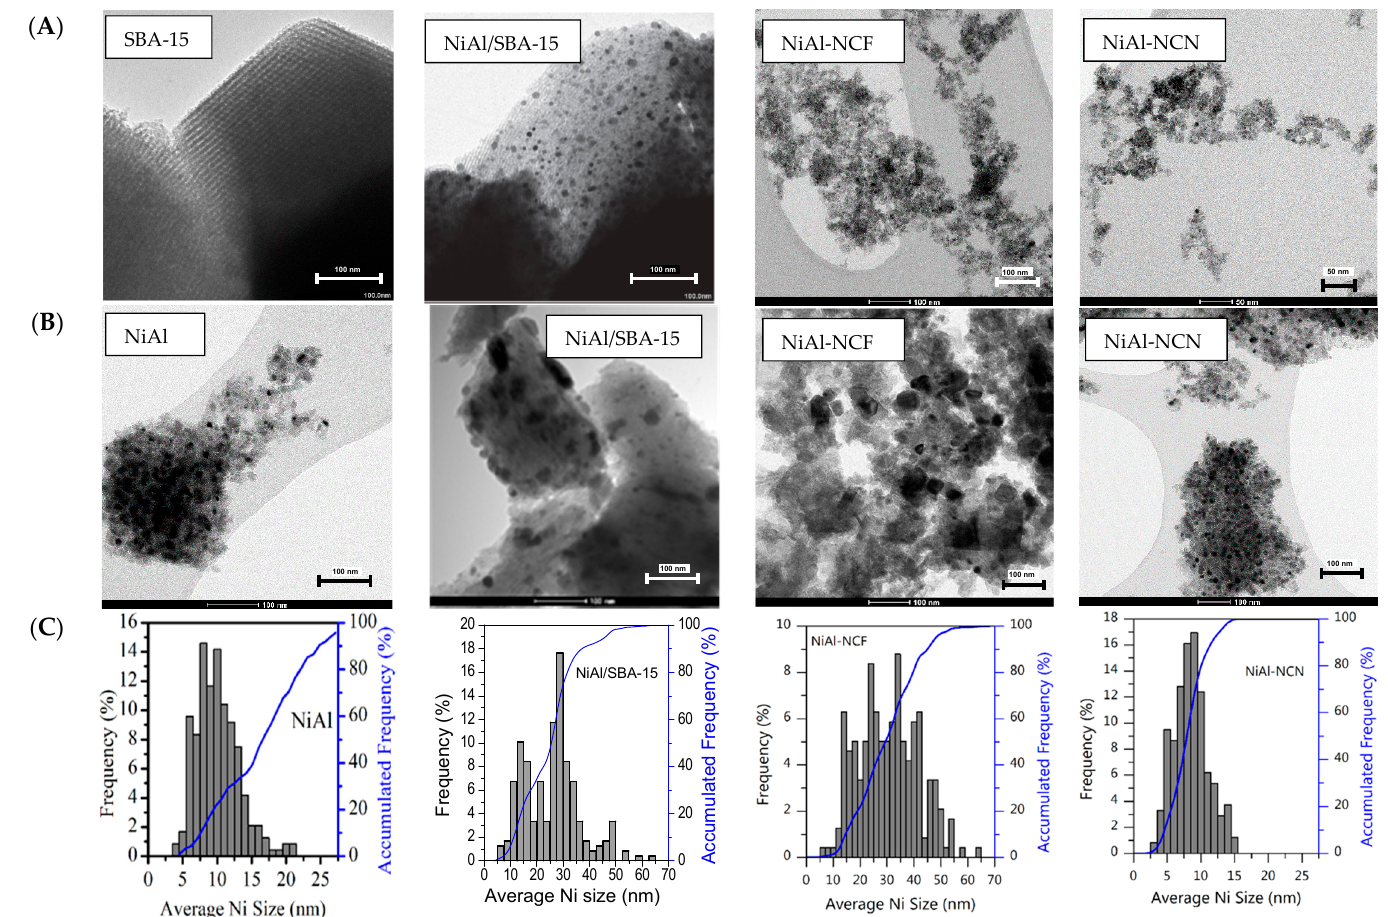
Figure 4. TEM images for ( A ) calcined and ( B ) fresh reduced forms of the solids. ( C ) Ni 0 particle size distributions.